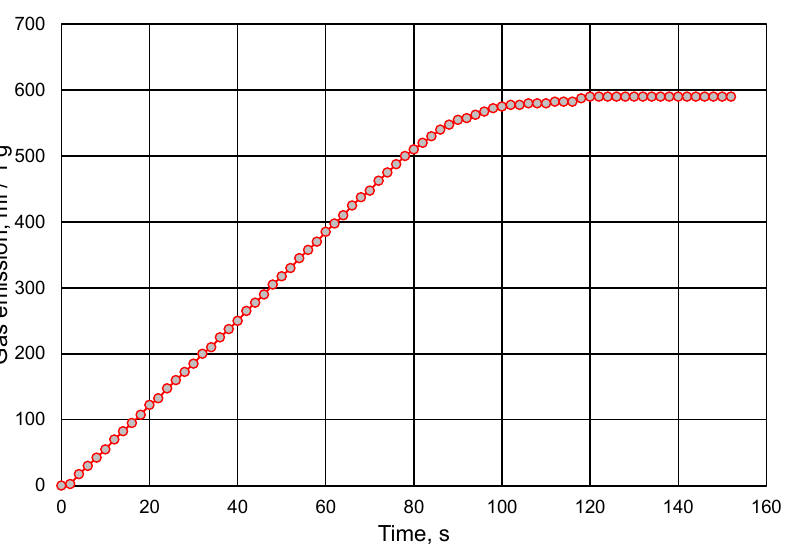
Figure 8. Measurement of gas emission of molding sands with different resin content. When comparing all parameters analyzed, to determine the best composition of the molding sand, from the point of view of weather conditions, sand quality, cost- effectiveness of the process and ecological aspect, it was found that the best is the molding sand with 100 weight parts of the grain matrix (in this case chromite matrix), 1.0–1.2% resin and 25% hardener in relation to the resin. The next step was to determine the effect of the amount of hardener added to the constant amount of resin dosed to the grain